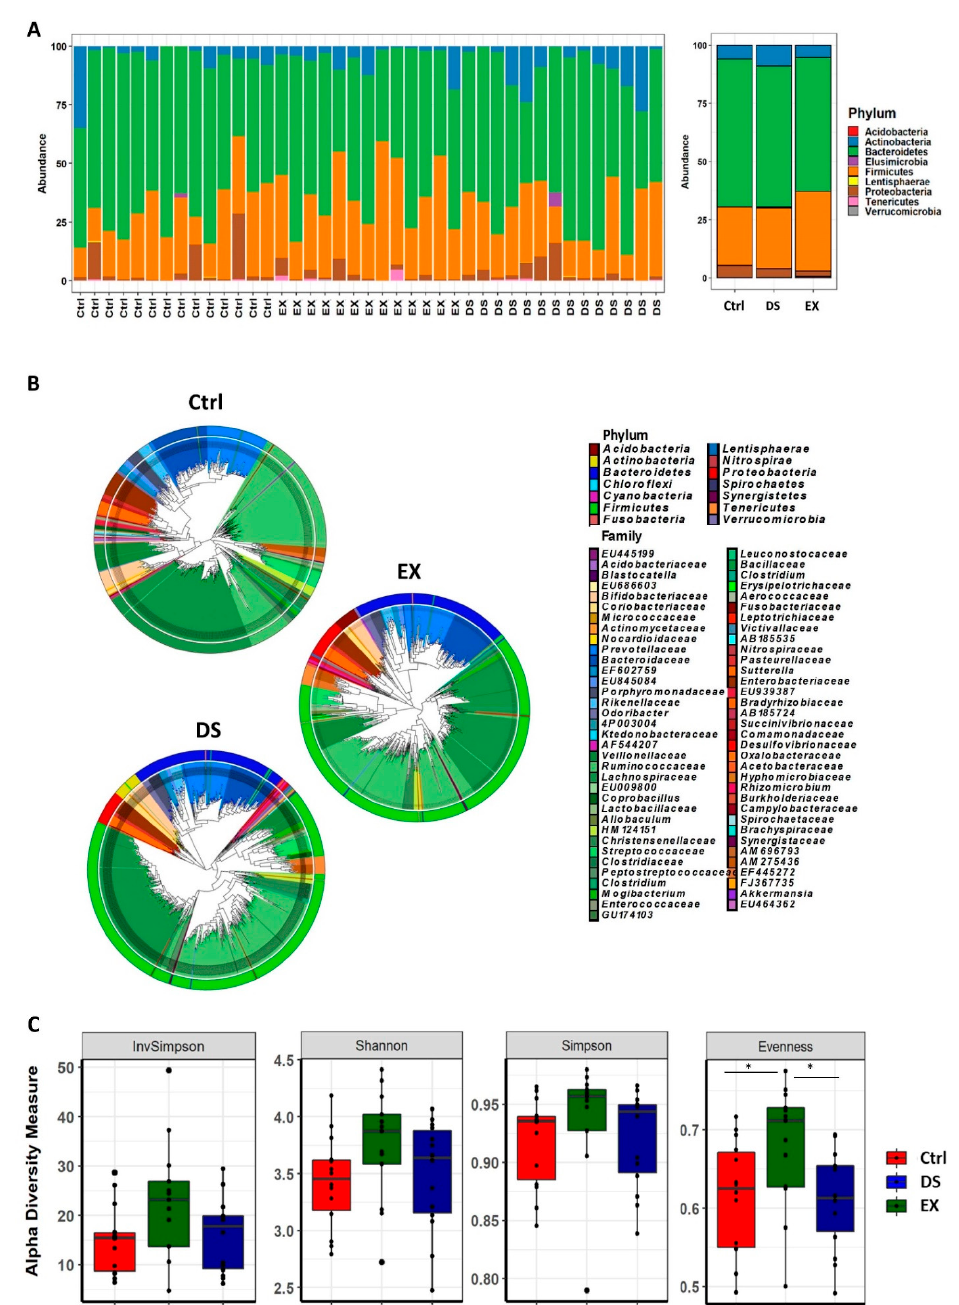
Figure 1. Changes in the composition of the gut microbiome at the phylum level after diet shift or exercise. ( A ) The relative compositional changes in the gut microbiome at the phylum level. ( B ) Maximum-likelihood phylogenetic tree comprising all of the taxa of the gut microbiome in the Ctrl, EX, and DS groups. The rings of the circular dendrogram represent the phylum level, and the corresponding family is depicted in the inner layer. ( C ) α -diversity indexes of the gut microbiome in the Ctrl, EX, and DS groups. α -Diversity values are indicated as the median ± standard deviation. * p value < 0.05 was considered as significant. Ctrl, EX, and DS represent the control, exercise, and diet shift groups,